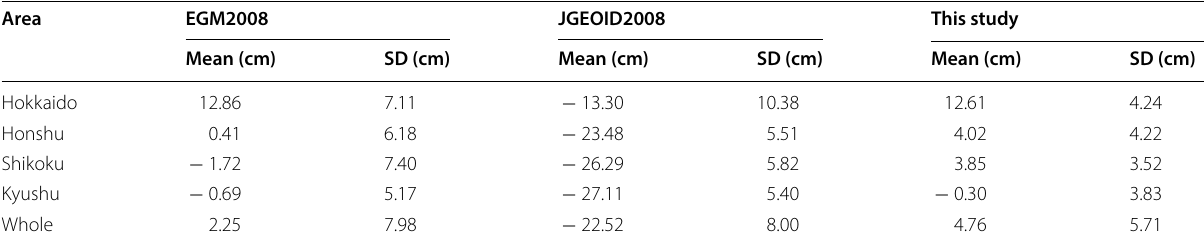
Table 2 Statistics of difference between gravimetric geoid models and GNSS/leveling geoid heights at 971 benchmarks for EGM2008, JGEOID2008, and this study